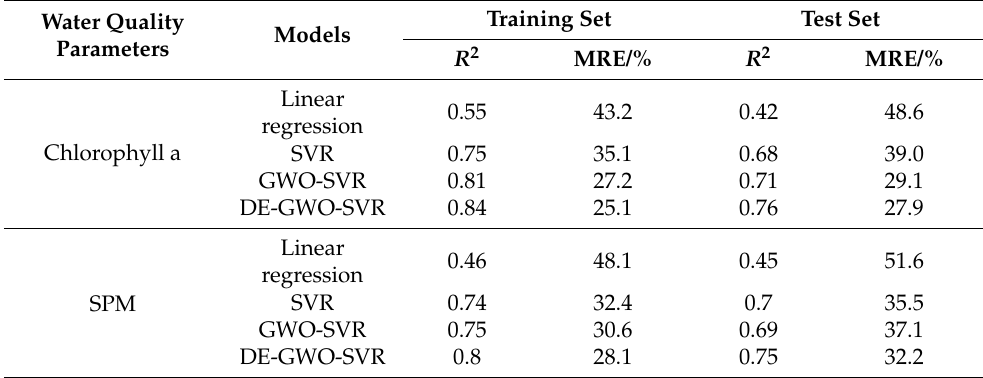
Table 1. Evaluation parameter results of training set and test